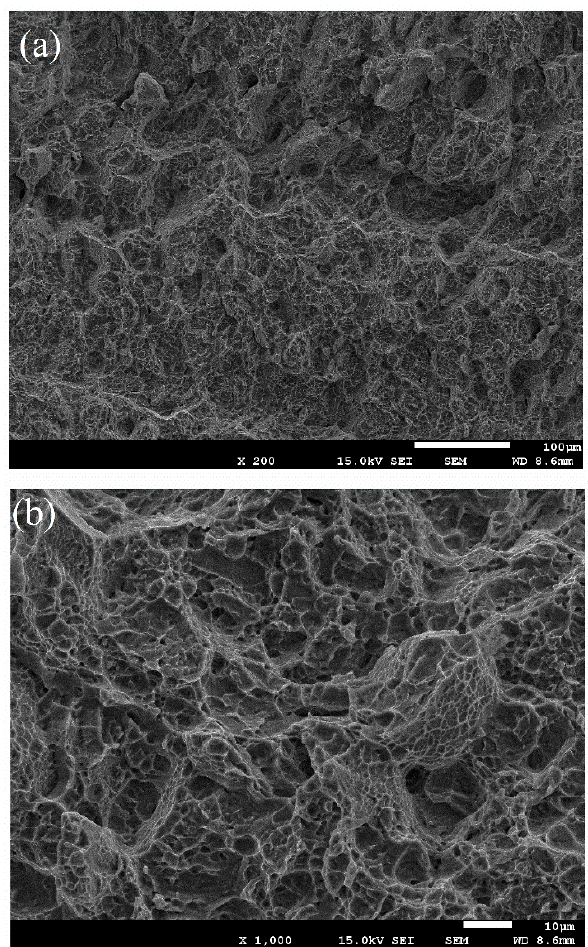
Figure 10. Fracture surface of W2 welded joint after tensile test performed at room temperature, ( b ) is the magnified view of ( a ).